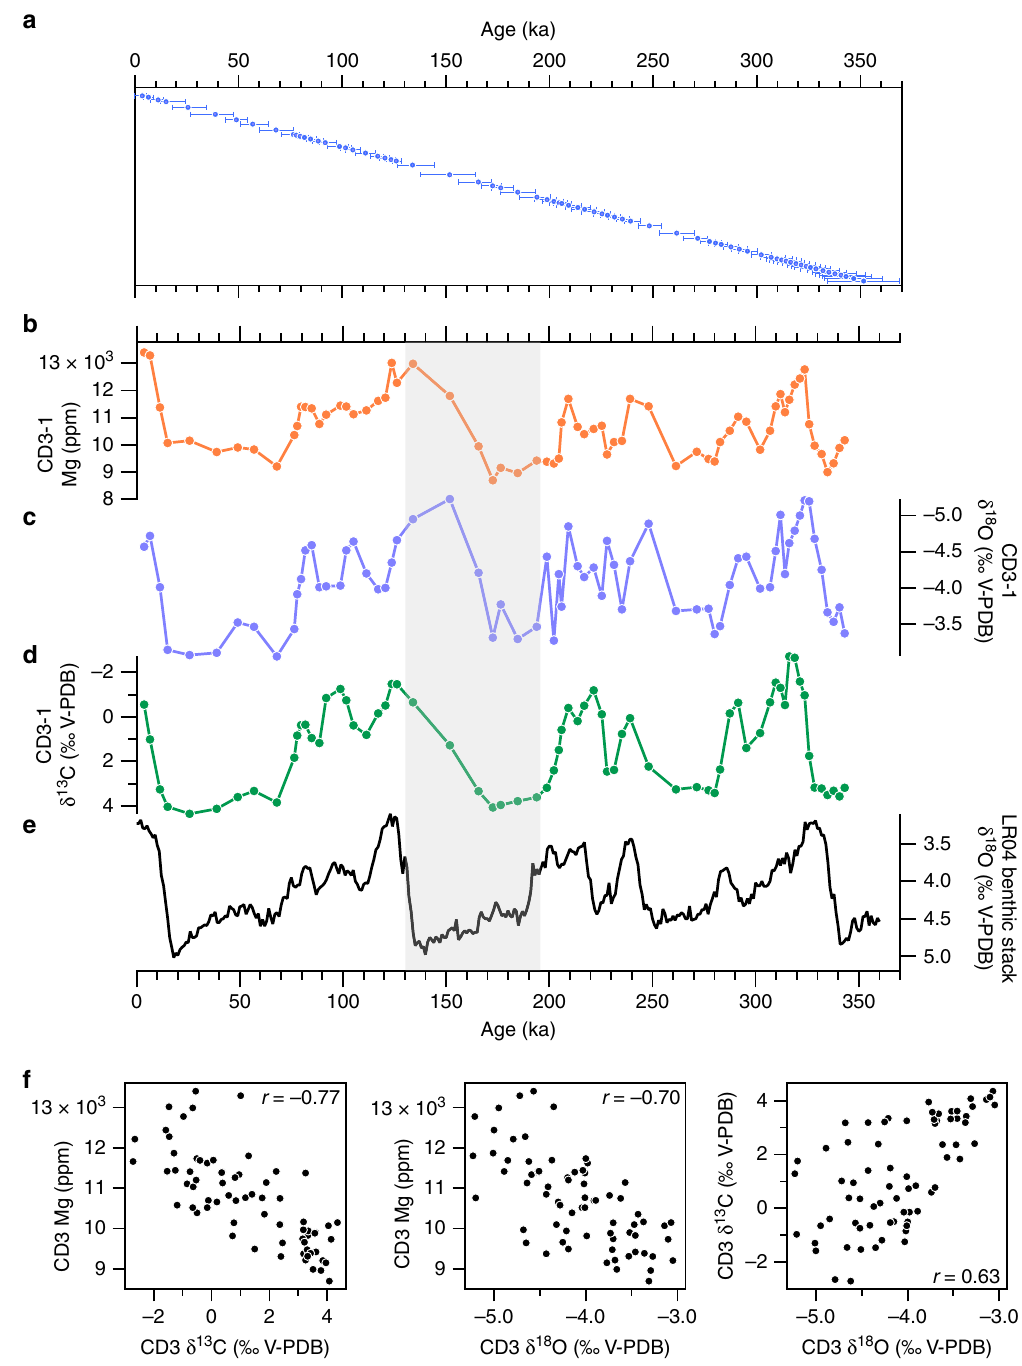
Fig. 2 CD3-1 data spanning the last 350,000 years. a The blue circles show the distribution across time of 115 radiometric ages (see Supplementary Data 1) on CD3-1 (see Supplementary Fig. 1 for the age-depth model and the age uncertainty time series). The error bars are 2 σ uncertainties based on the U-Th age calculations. b – d Mg, δ 18 O and δ 13 C series from CD3-1 sampled at 1 mm resolution (see ‘ Methods ’ ). e The Lisiecki and Raymo 51 LR04 benthic δ 18 O stack. The grey vertical band is the MIS 6-to-Termination II (~195 – 130 ka) interval where the greatest age discrepancy occurs between the CD3-1 series and the benthic δ 18 O (see main text for discussion). f Scatterplots and Pearson ’ s r correlation coef fi cients for CD3-1 data shown in b – d . All r -values are statistically signi fi cant at p <